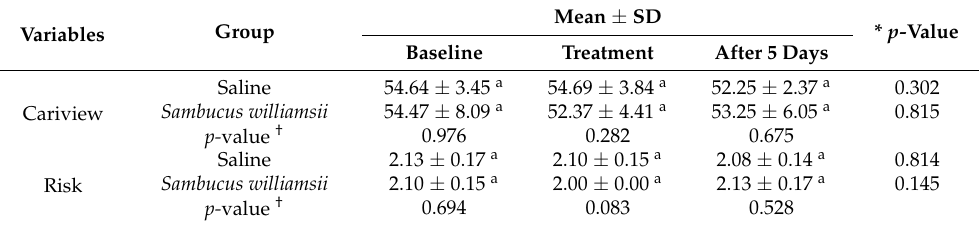
Table 3. Changes in the Cariview scores of two groups.